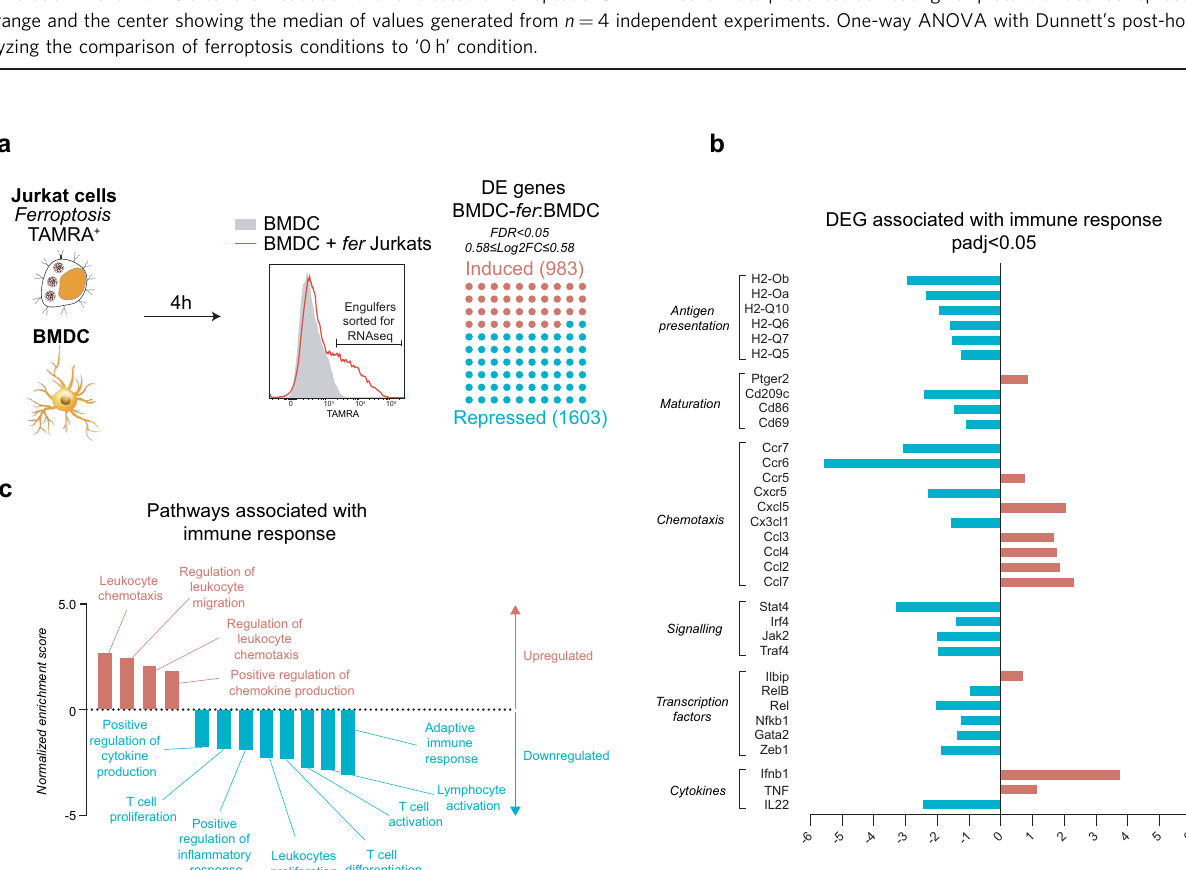
Fig. 3 Initial ferroptosis impairs the maturation of dendritic cells. a MCA205 cells with depleted levels of GPX4 and doomed for ferroptosis were co- incubated with dendritic cells for 16 h. To address the role of each ferroptosis stage on the dendritic cell maturation, iGPX4KD cells at different stages of cell death were used. In all conditions iGPX4KD cells reached terminal stage during the co-culture. b The analysis of the maturation of dendritic cells incubated with ferroptotic cells. The levels of CD86, CD40, PD-L1 and percentage of dendritic cell population expressing high levels of MHCII was assessed by fl ow cytometry measurements. Data from n = 3 independent samples for CD40 and MHCII measurement and n = 4 independent samples for CD86 and PD-L1. Data are presented as fl oating bar plots with box bounds representing the range and center showing the median of obtained measurements. One- way ANOVA, with Dunnett ’ s post-hoc test analyzing comparison to ‘ 0 h ’ sample. c The analysis of cytokine production from the dendritic cells incubated with ferroptotic cells. Data from n = 4 independent biological replicates and presented as fl oating bars with bar limits showing the range and the center describing the median. One-way ANOVA, with Dunnett ’ s post-hoc comparing results from the co-cultures to the untreated bone marrow-derived dendritic cells (BMDC). d The analysis of phosphatidylserine exposure on the surface of the ferroptotic cells at different stages of cell death. Representative contour plot of fl ow cytometry analysis using Annexin V and 7-AAD. Bar graphs show the mean ± SEM of n = 3 independent experiments. e The level of phagocytosis of untreated and undergoing the initial or terminal ferroptosis. CypHer-labeled MCA205 cells were incubated with CFSE-labeled bone marrow-derived dendritic cells (BMDC) for 2 h. Afterwards the phagocytosis was determined by the detection of CypHer fl uorescence in CFSE-stained BMDC. Cytochalasin D and Fer1 were used as inhibitors of phagocytosis and lipid peroxidation respectively. Data from n = 3 independent biological samples and is presented as fl oating bars with bounds representing the range and the center showing the median of % of phagocytic BMDC. Two-way death (upper panel) and the gating strategy for phagocytosis detection. f The analysis of the dendritic cells phagocytosis of the terminal ferroptotic cells signi fi cant. g The analysis of dendritic cells phagocytosis of terminal ferroptotic cells with blocked calreticulin. Data presented as fl oating bars with bounds lipid droplets accumulation using BODIPY 493/503nm probe. Bone marrow-derived dendritic cells (BMDC) were incubated with iGPX4KD cells at